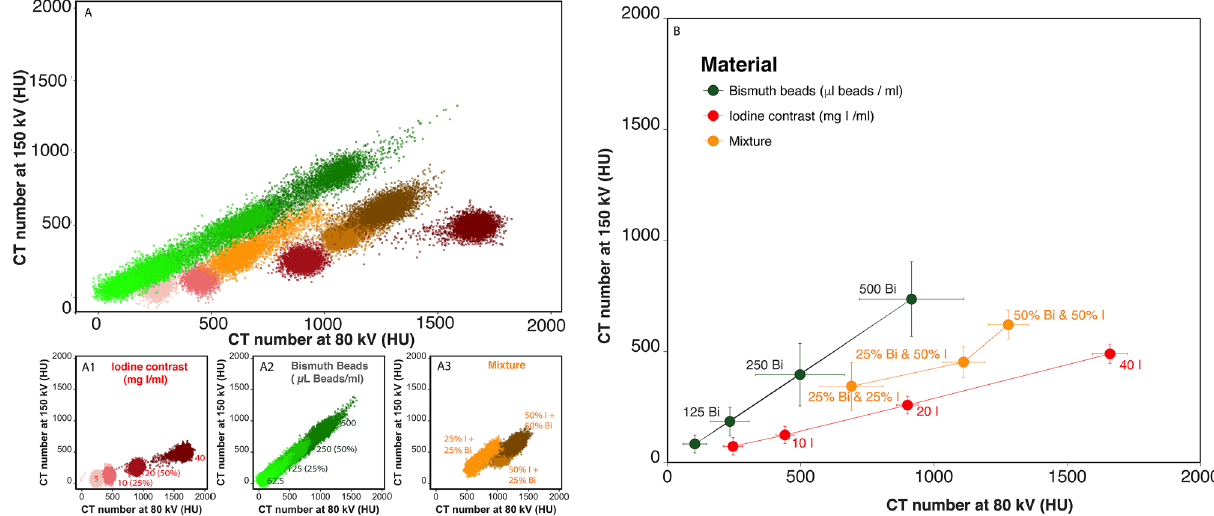
Figure 6. Correlation of CT numbers (HU) on dual energy CT at 80 kVp vs Sn150 kVp: iodine, bismuth beads ( 6 ) and mixture of both. ( A ) Scatter plots of the CT numbers (HU) derived from the 80 kVp and Sn150 kVp scans for each voxel. Subplots are shown as ( A1 ) iodine (red), ( A2 ) bismuth (green), and ( A3 ) a mixture of both (orange). ( B ) The average and standard deviation (bars) of the CT number (HU) derived from the 80 kVp and Sn150 kVp scans for each tube.